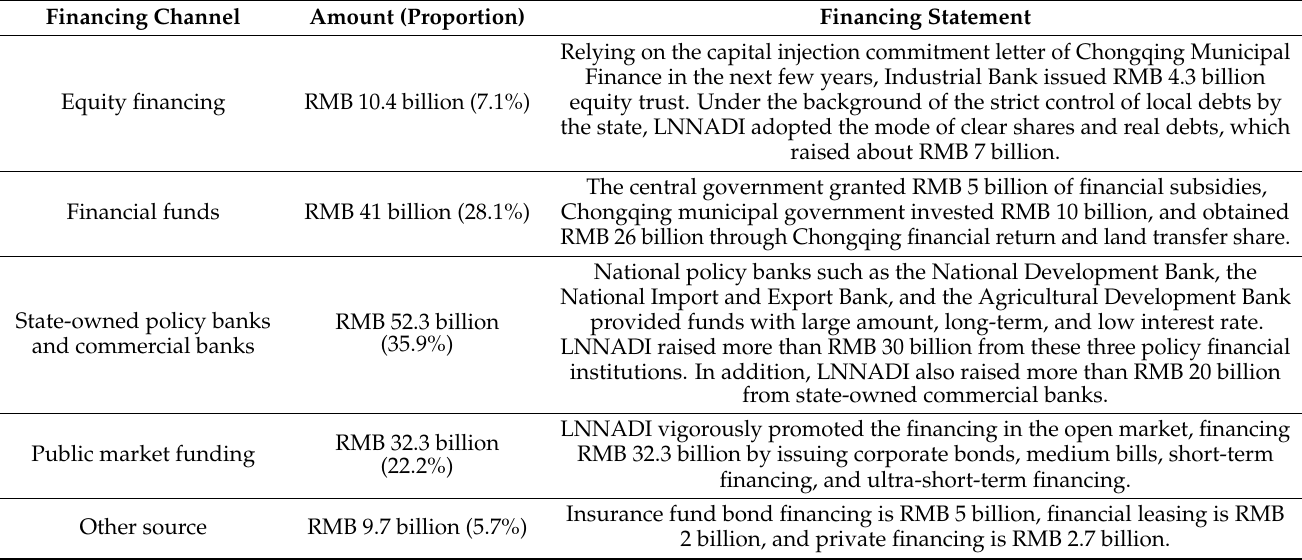
Table 4. Financing structure of LNNADI, 2010–2015 (source: the author compiled from interviews with local officials, 18 May